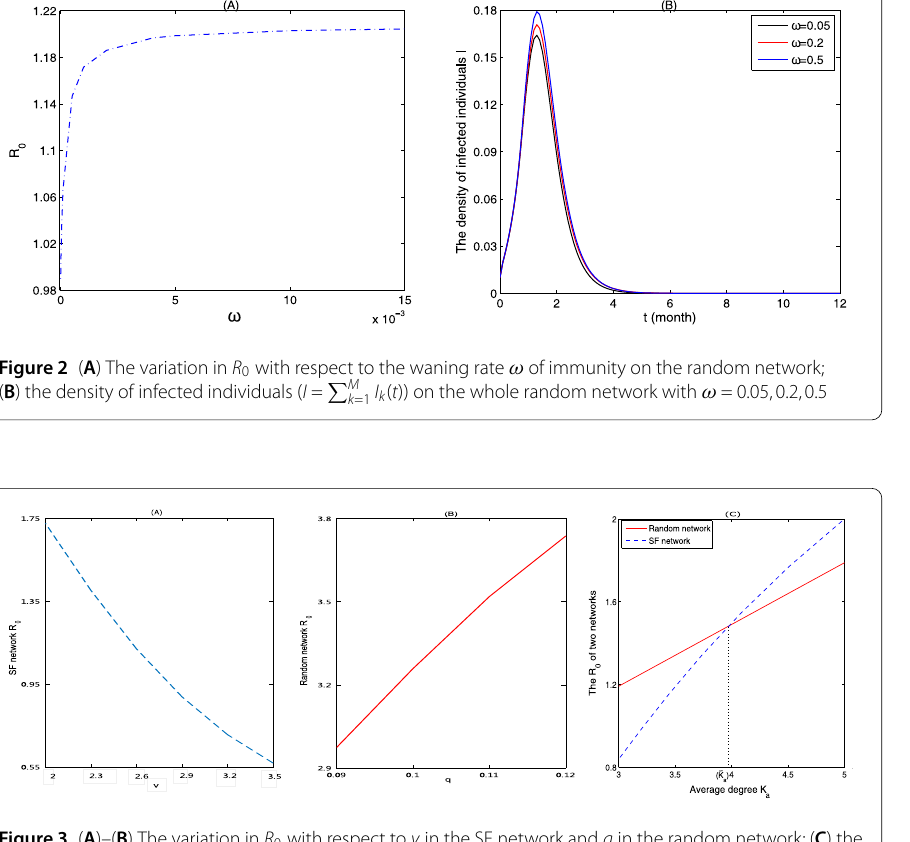
Figure 3 ( A )–( B ) The variation in R 0 with respect to v in the SF network and q in the random network; ( C ) the comparison of R 0 under different networks (SF network and random network) with the same average degree. ¯